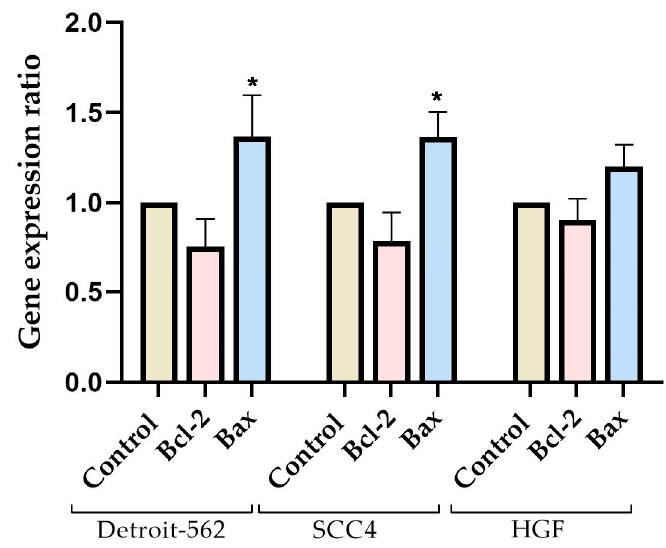
Figure 9. Relative fold-change expression of mRNA of pro-apoptotic (Bax) and anti-apoptotic (Bcl-2) markers in Detroit-562, SCC4, and HGF cells immediately after UVB (2.5 J/cm 2 ) exposure. The mRNA expression levels were normalized to 18 S expression, and the mean values ± SD of the three independent experiments were presented based on a one-way ANOVA analysis with Dunnett’s post hoc test, which were used to identify the statistical differences (* p < 0.05).